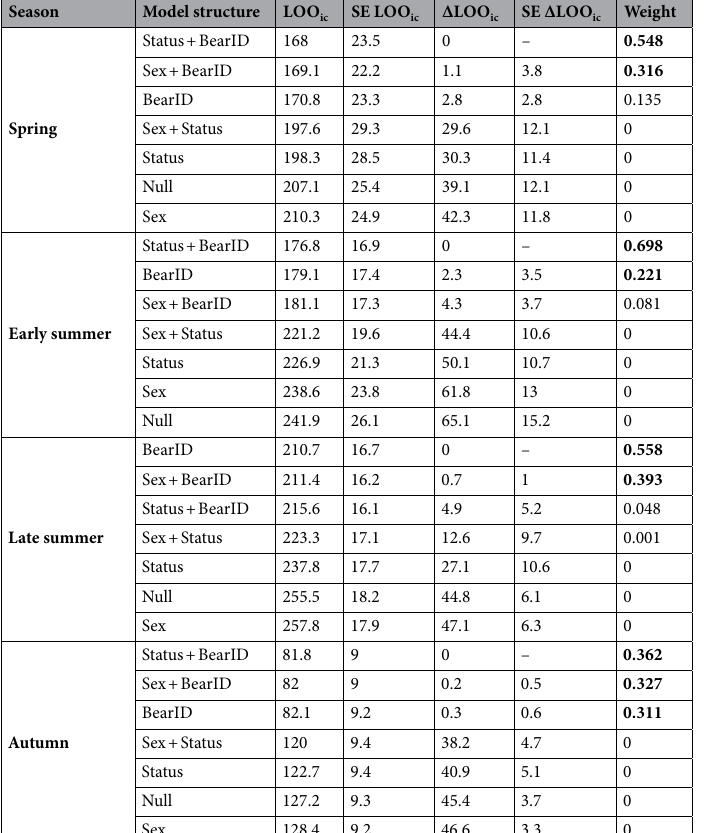
Table 3. Model selection of seasonal sets of Stable Isotope Mixing Models to assess factors affecting the assimilated diet of Apennine bears (June–September 2014, Abruzzo Lazio and Molise National Park, central Italy). LOO ic : LOO information criterion; SE LOO ic : standard error of LOO ic ; Δ LOO ic : difference between each model and the model with lowest LOO ic ; SE Δ LOO ic : standard error of the difference between each model and the model with lowest LOO ic ; Weight: relative support for each model, calculated as Akaike weights. Akaike weights > 0.2 were highlighted in bold.